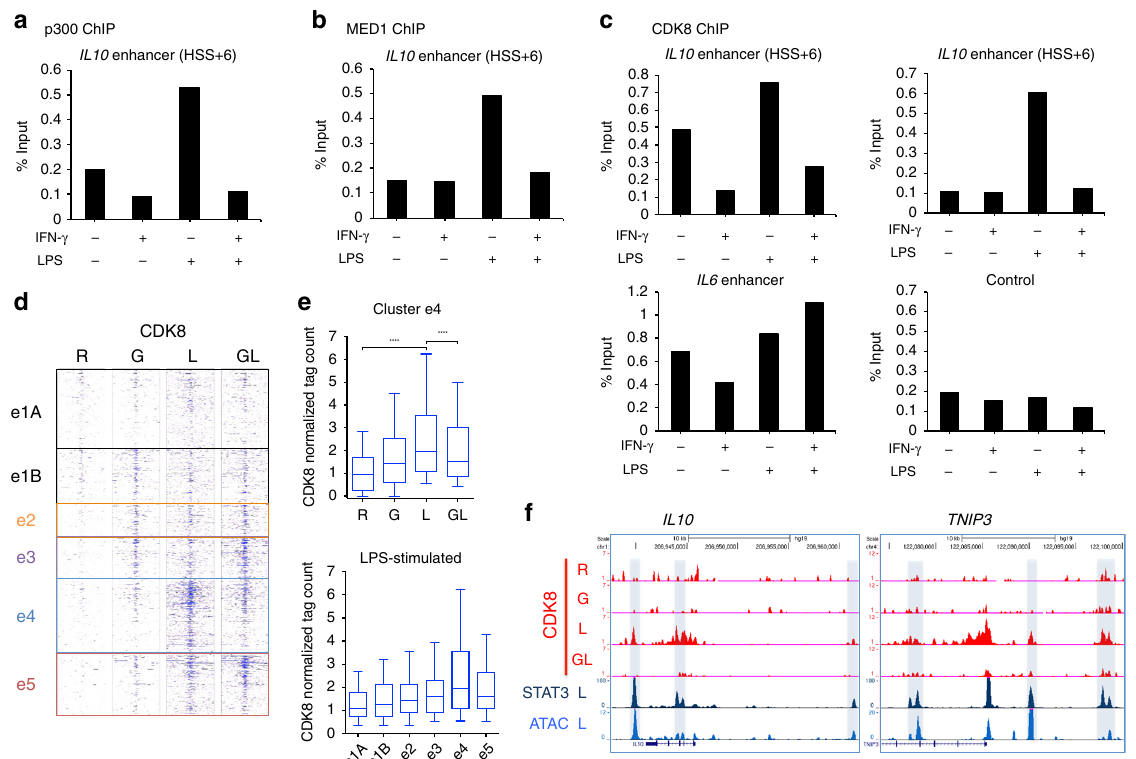
Fig. 5 IFN- γ suppresses coactivator and CDK8 recruitment to e4 enhancers. a ChIP-qPCR analysis of p300 occupancy at the e4 enhancer (HSS + 6) of IL10 . b ChIP-qPCR analysis of MED1 occupancy at the e4 enhancer (HSS + 6) of IL10 . c ChIP-qPCR analysis of CDK8 occupancy at e4 enhancers (HSS + 6 and HSS-16) of IL10 and e5 enhancer of IL6 . d Heatmap showing CDK8 ChIP-seq signals at each enhancer cluster de fi ned in Fig. 2a. e The boxplot (top) indicates normalized tag counts at e4 enhancer in the four indicated conditions. **** p < 0.0001, paired-samples Wilcoxon signed-rank test. The boxplot (bottom) indicates normalized tag counts at each enhancer cluster in LPS-stimulated macrophages. Boxes encompass the twenty- fi fth to seventy- fi fth percentile changes. Whiskers extend to the tenth and ninetieth percentiles. The central horizontal bar indicates the median. f Representative UCSC Genome Browser tracks displaying normalized tag-density pro fi les at e4 enhancers of IL10 and TNIP3 in the four indicated conditions (CDK8) and the LPS- stimulated condition (STAT3 ChIP-seq and ATAC-seq). Data are representative of three independent experiments ( a – c ), or depict one ChIP experiment using pooled samples from independent experiments using four different donors ( d , e